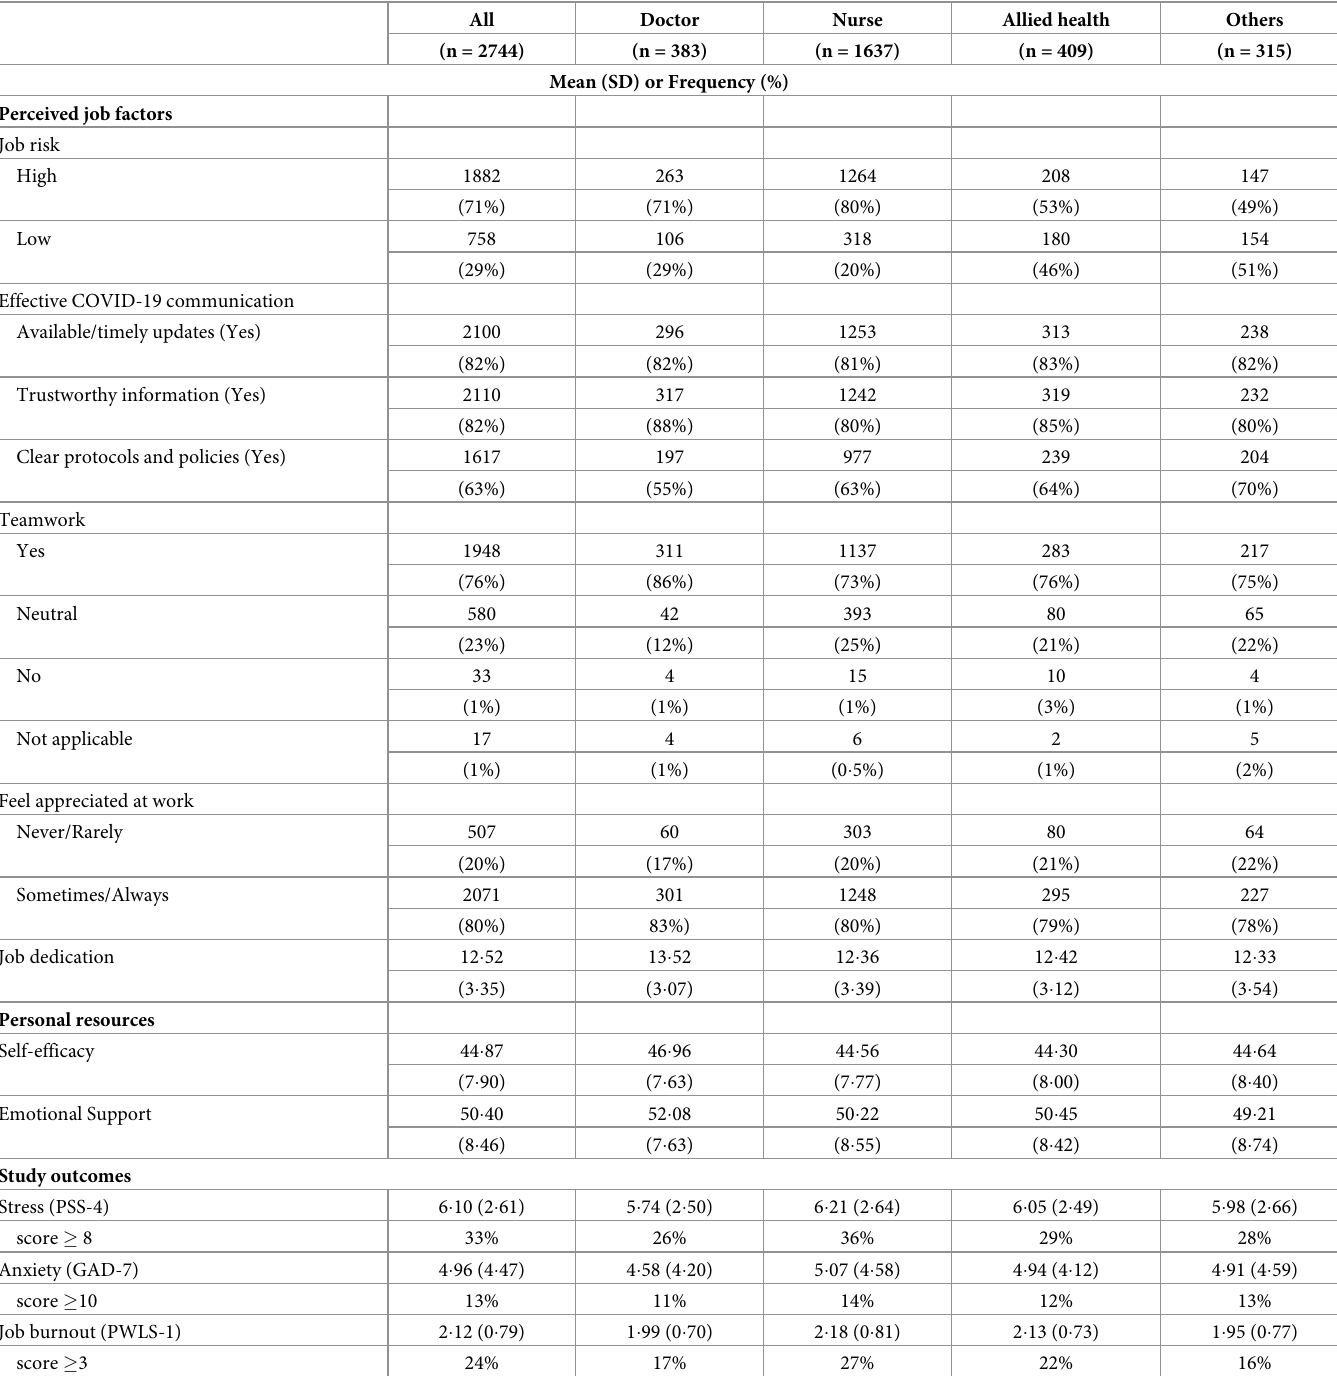
Table 2. Healthcare worker-perceived job factors, personal resources, and study outcomes at initial survey ( N = 2744).